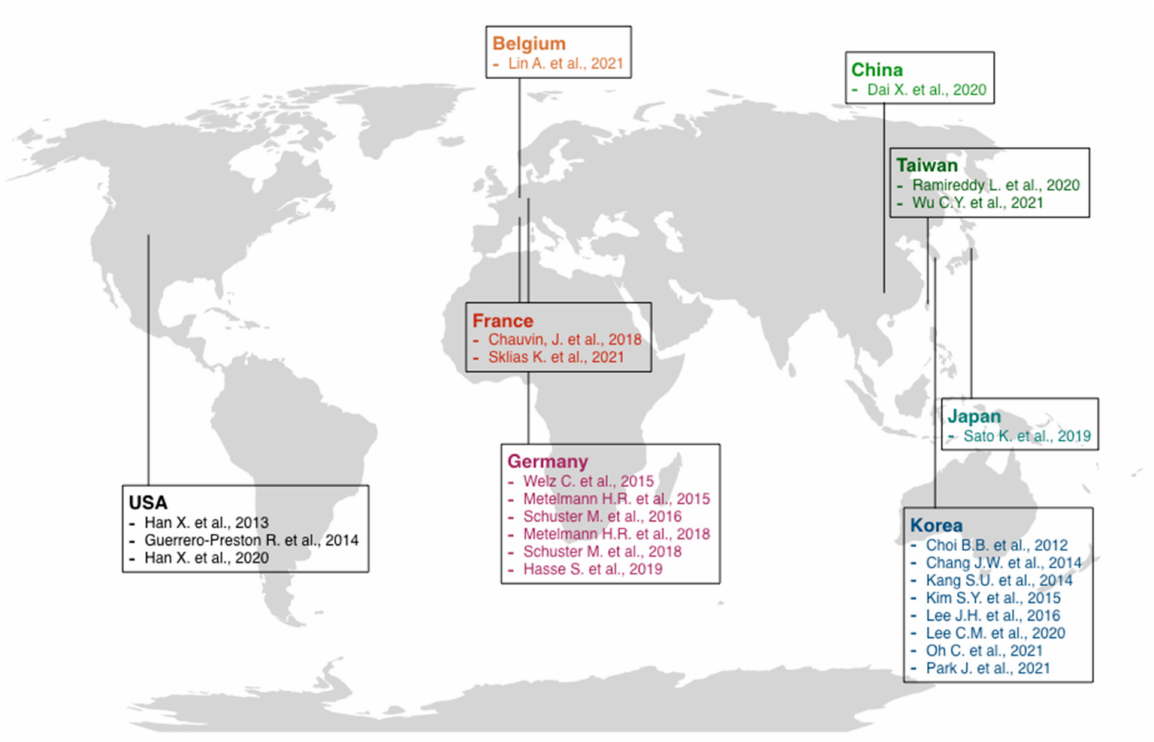
Figure 3. Schematic representation of the most relevant cold atmospheric plasma studies [5,6,15,23,36– 38,71–87] published in various